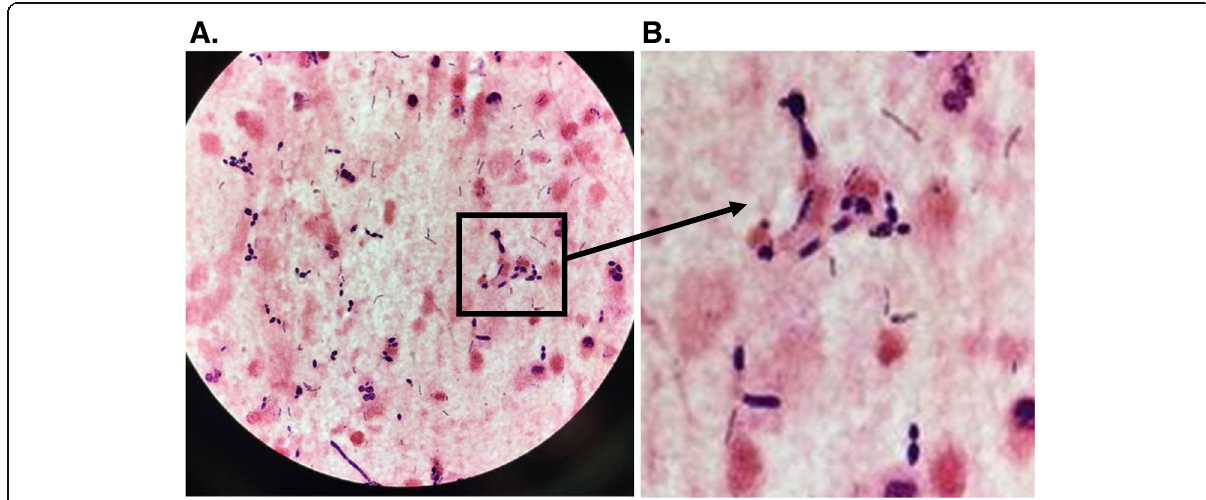
Fig. 1 A . Sputum Gram stain (case 5) at 1000x magnification showing polymorphonuclear leukocytes and monocytes. The red background indicates protein in secretions. Absence of epithelial cells indicates absence of contamination by oropharyngeal secretions. Large numbers of budding yeast forms are seen, many of which are intracellular, with some pseudohyphae. Many fine Gram positive rods are also seen. B . Enlargement of boxed area shows what appear to be deteriorating pseudohyphae. Culture yielded 4X10 6 Candida tropicalis and 1.6 × 10 8 Lactobacillus